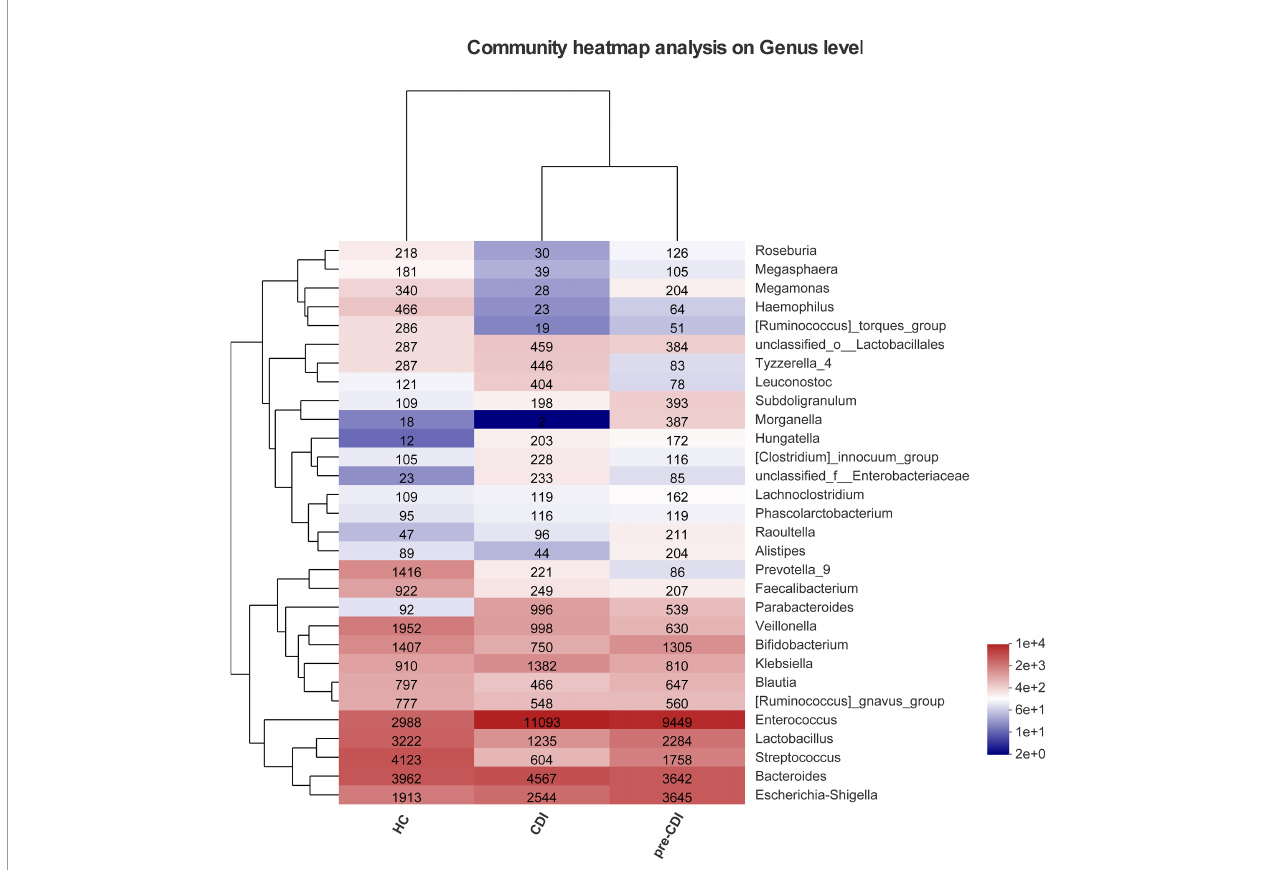
FIGURE 2 | Heatmap representing the relative abundance of Top 30 genus-level in the CDI, pre-CDI and HC samples. The heatmap displays the abundant V3-V4 sequences of bacterial genera (rows) in three groups (columns). For each genus, the relative abundance is represented by speci fi c values and a color gradient from dark blue (low abundance) to bright red (high abundance). The tree diagram displays the clustering in layers.